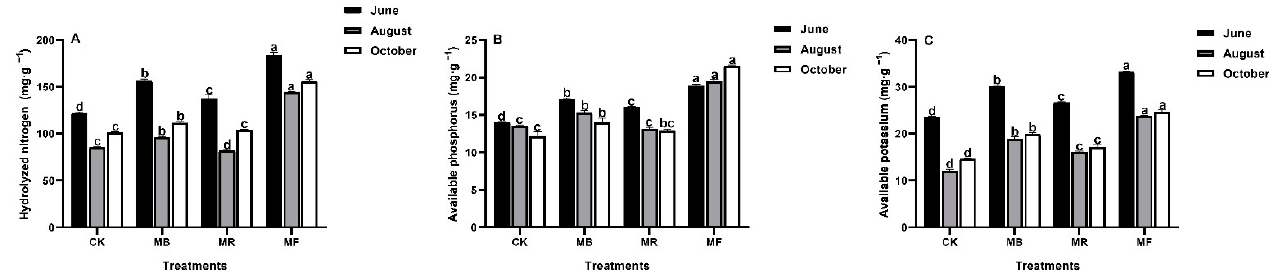
Figure 1. The effect of mulch treatments on soil chemical properties, where MB: bamboo leaves mulch, MR: rice husks mulch, MF: organic fertilizers mulch, and CK: control, respectively. ( A ) Hydrolyzed nitrogen (HN); ( B ) Available phosphorus (AP); ( C ) Available potassium (AK). Various letters on bars show the significant differences ( P < 0.05) with vertical bars as standard errors ( n =